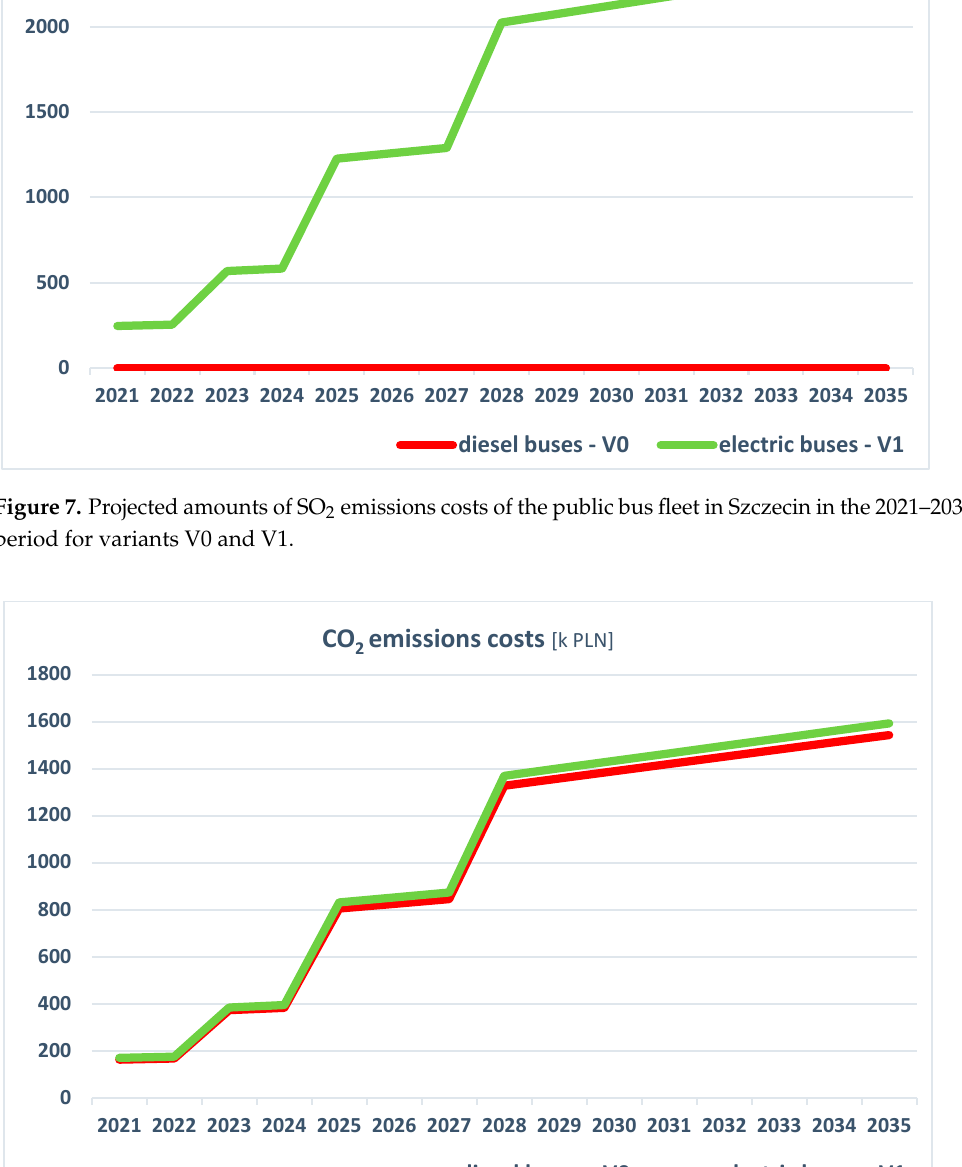
Figure 8. Projected amounts of CO 2 emissions costs of the public bus fleet in Szczecin in the 2021–2035 period for variants V0 and V1.